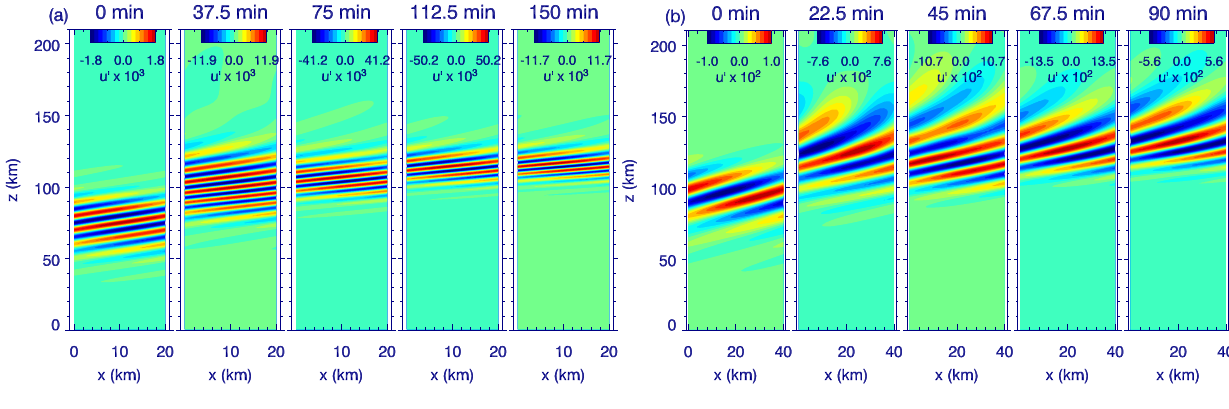
Fig. 11. Same as in Fig. 10, but for the non-isothermal